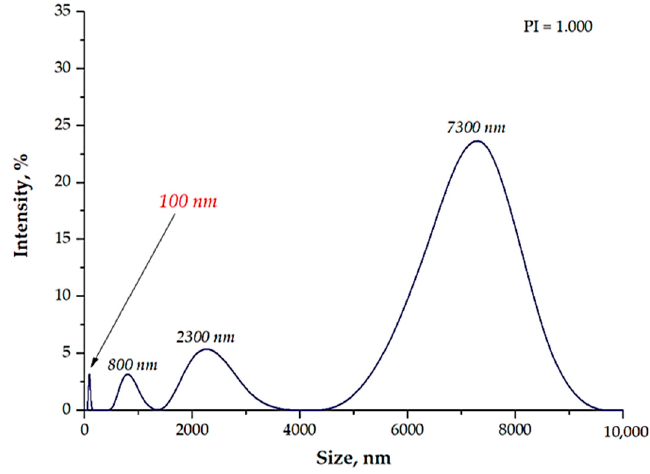
Figure 4. The size analysis of the particles in the suspension obtained as a result of the synthesis performed using the 3% arabic gum solution.